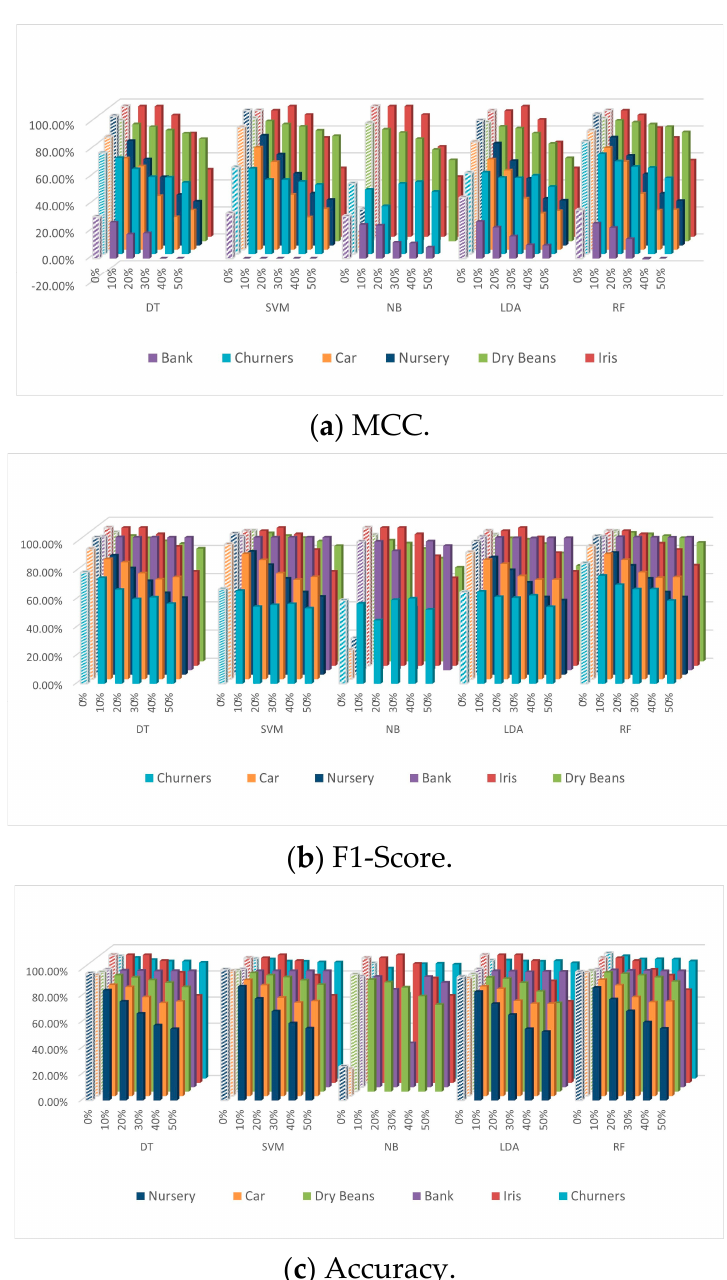
Figure 4. Performance of the five classifiers on the six datasets with different ratios of MNAR MVs imputed using KNN.